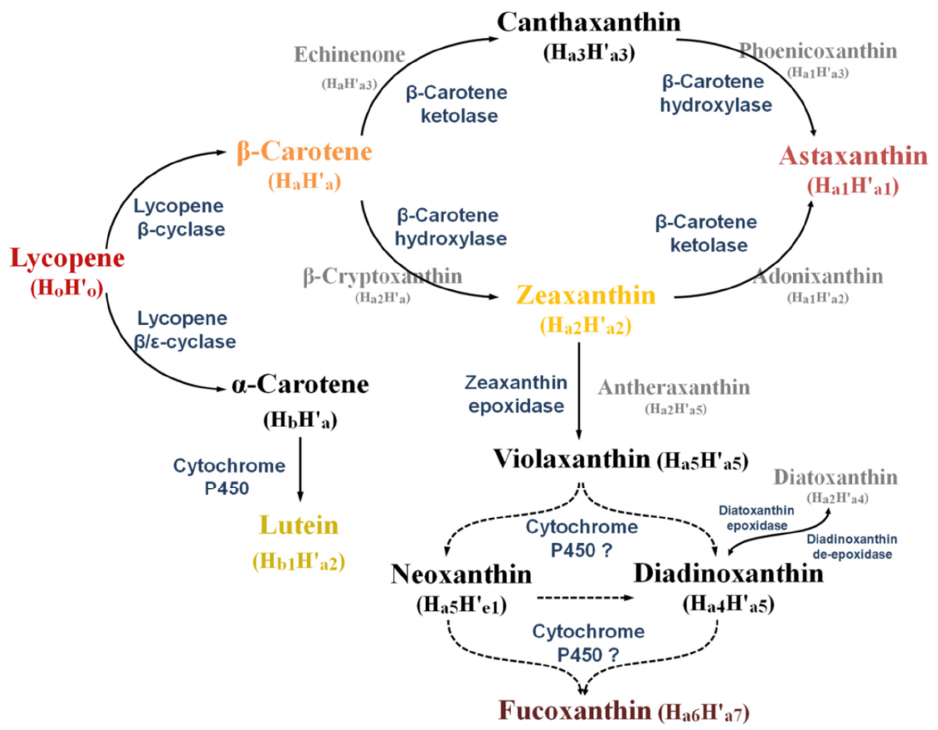
Figure 2. Metabolic pathways for astaxanthin synthesis from lycopene. Arrows indicate catalyses, with enzymes shown in blue. Dashed arrows indicate hypothesized reactions. Reaction intermediates are shown in gray. (From: Wang et al. [35].)